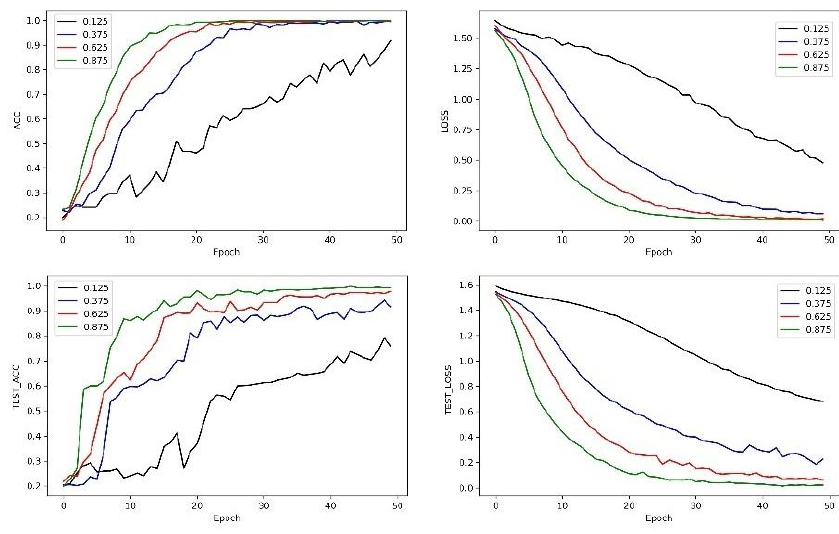
Figure 9. Results of TM2 in different working conditions.